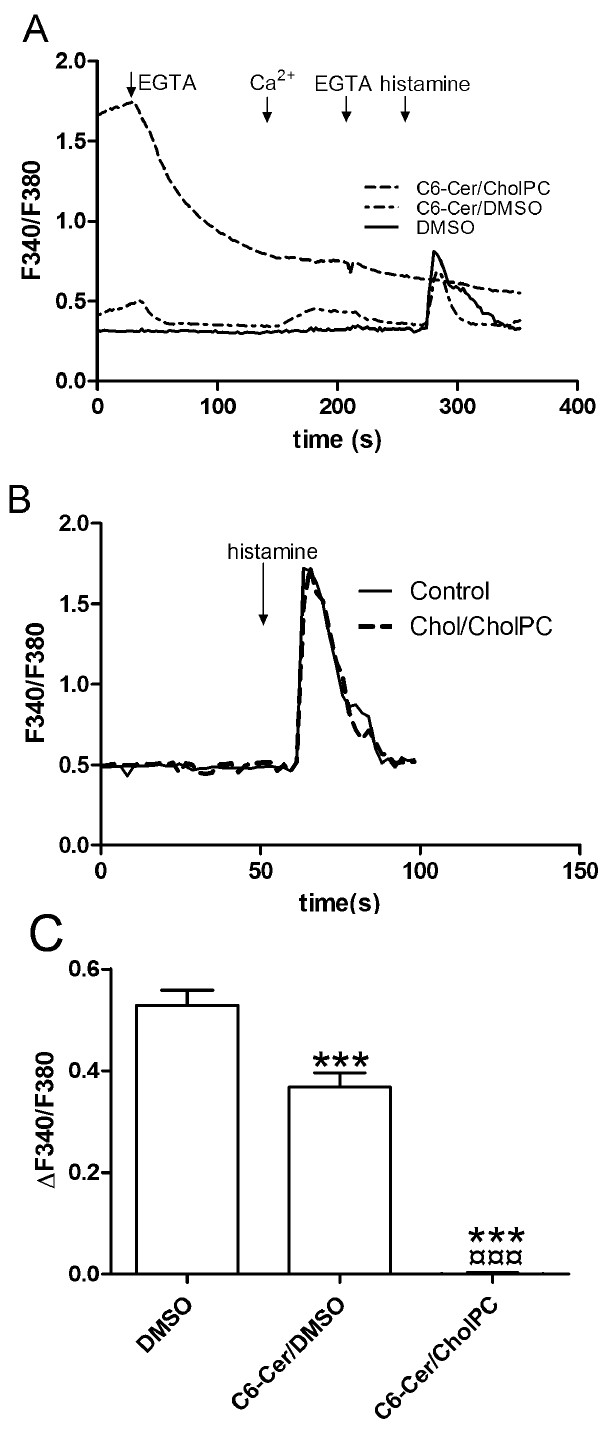
Figure 4. C6-Cer/CholPC disrupts cytosolic calcium homeosta- sis in HeLa cells. The cells (panel A) were preincubated for 90 min with 0.05 mM C6-Cer/CholPC or C6-Cer/DMSO, and changes in intracellular Ca 2 + levels were measured using Fura 2-AM. DMSO alone was used as control. The cells were stimulated as indicated by the arrows (150 m M EGTA, 1 mM Ca 2 + , and 10 m M histamine). The Ca 2 + traces are averages from 33 individually measured cells that were randomly selected. In panel B, cells were instead treated with Chol/ CholPC or DMSO (control) and stimulated with 10 m M histamine in calcium containing HBSS buffer. The Ca 2 + traces are averages from